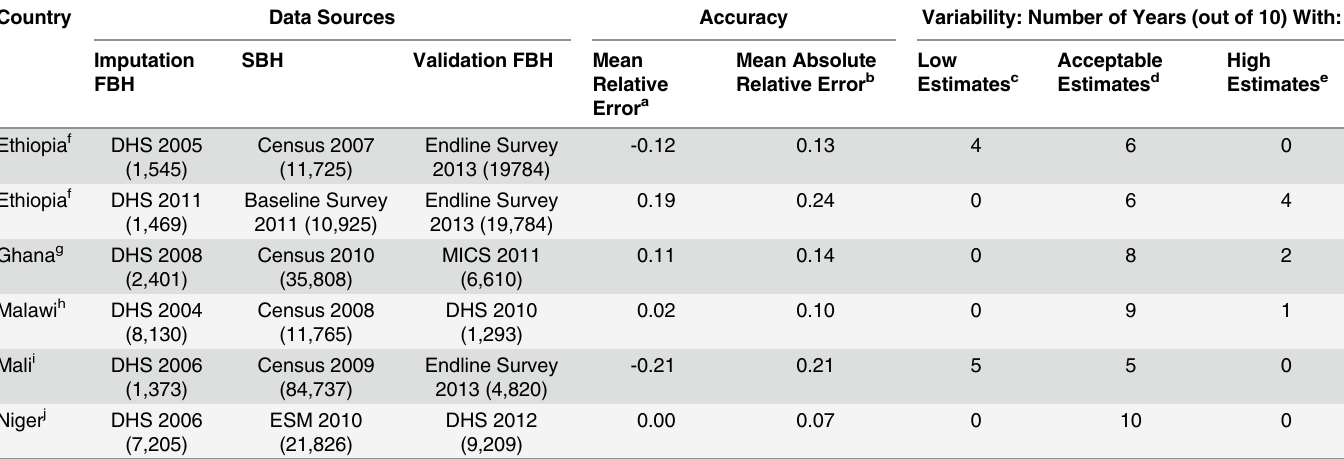
Table 2. Summary of Average Accuracy and Variability of Birth History Imputation Annual Estimates of Under-Five Mortality Rates Relative to Vali- dation Estimates. Country Data Sources Accuracy Variability: Number of Years (out of 10)